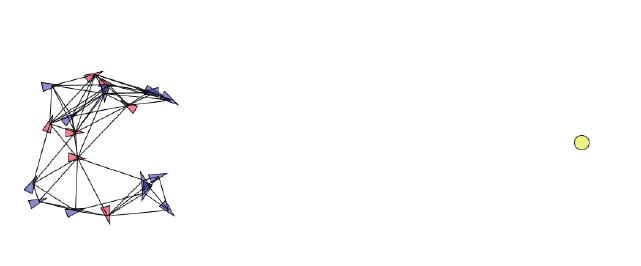
Figure 4: Beginning of the simulation: The (cid:13)ock is unstable. There are many leaders in a (cid:13)ock and the direction of movement is not decided yet. Red: leadership value (cid:11) (cid:21) 0 : 5(= leader ) , Blue: leadership